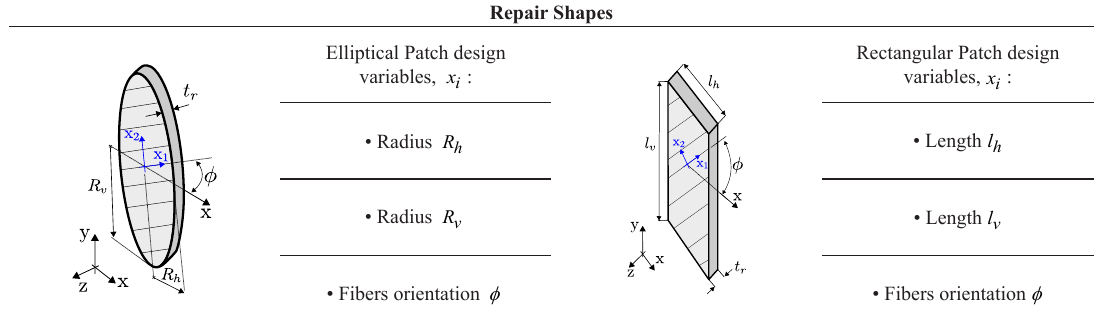
Table 3. Base shapes tested.